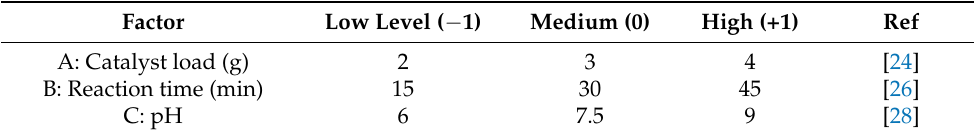
Figure 1. Schematic representation of the photocatalytic process via response surface methodology. Table 1. Box-Behnken design matrix for input